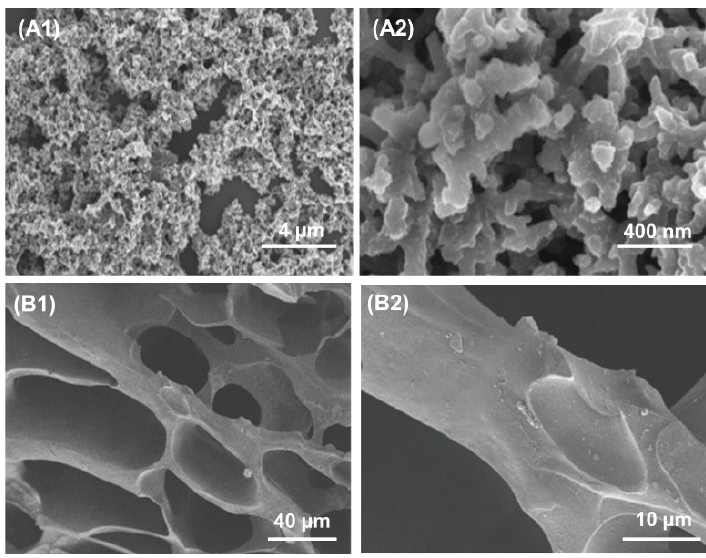
Figure 3. SEM images of PA-PANI ( A1 , A2 ) and 1/5-PA-PANI/PAAm cryogels ( B1 , B2 ). Figure 3B are SEM images of 1/5-PA-PANI/PAAm cryogel with two